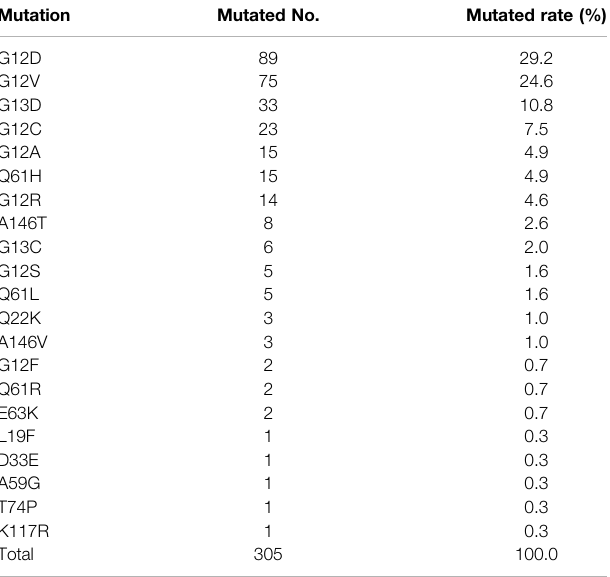
TABLE 2 | KRAS mutations identi fi ed in rare tumors. Mutation Mutated